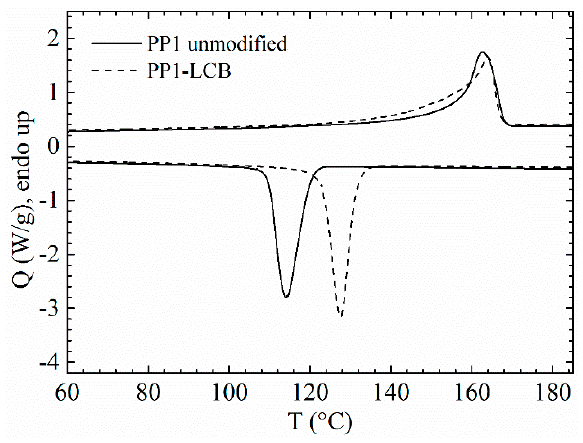
Figure 5. Changes in thermal properties for linear and LCB-PP1.